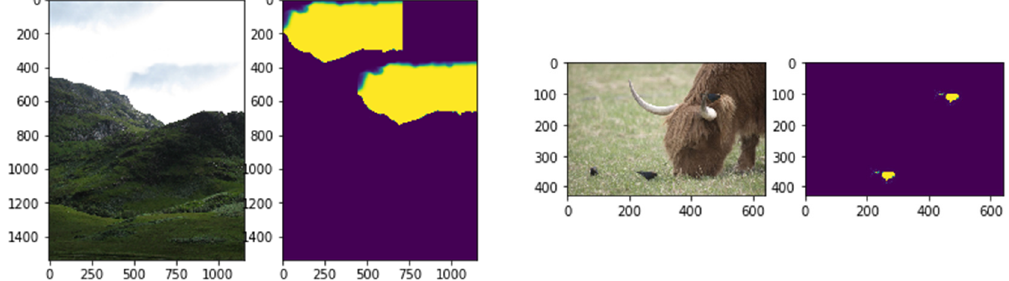
Figure 6. Some examples of forgery-dDetection. The first and third columns represent the forged images. The second and fourth columns represent the detection results of the proposed model.